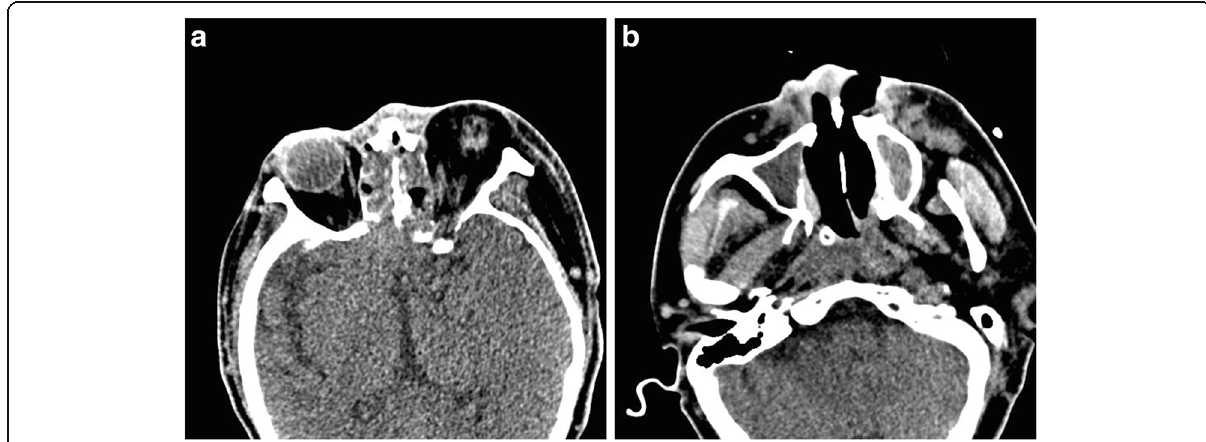
Fig. 2 a Computed tomography (CT) scanning of the brain and orbits revealed extensive involvement of the bilateral intranasal sinuses, orbits, extraocular muscles, and soft tissues. Increased soft tissue density was evident in the bilateral maxillary sinus, ethmoid sinus, sphenoid sinus, and around the orbits. Dilatation of the extraocular muscles was also observed, as was erosion of the left lateral wall of the sphenoid and cribriform plate. b Perforation of the patient ’ s nasal septum affected the left nasal cavity, with evidence of hard palate and left nasal wing involvement and